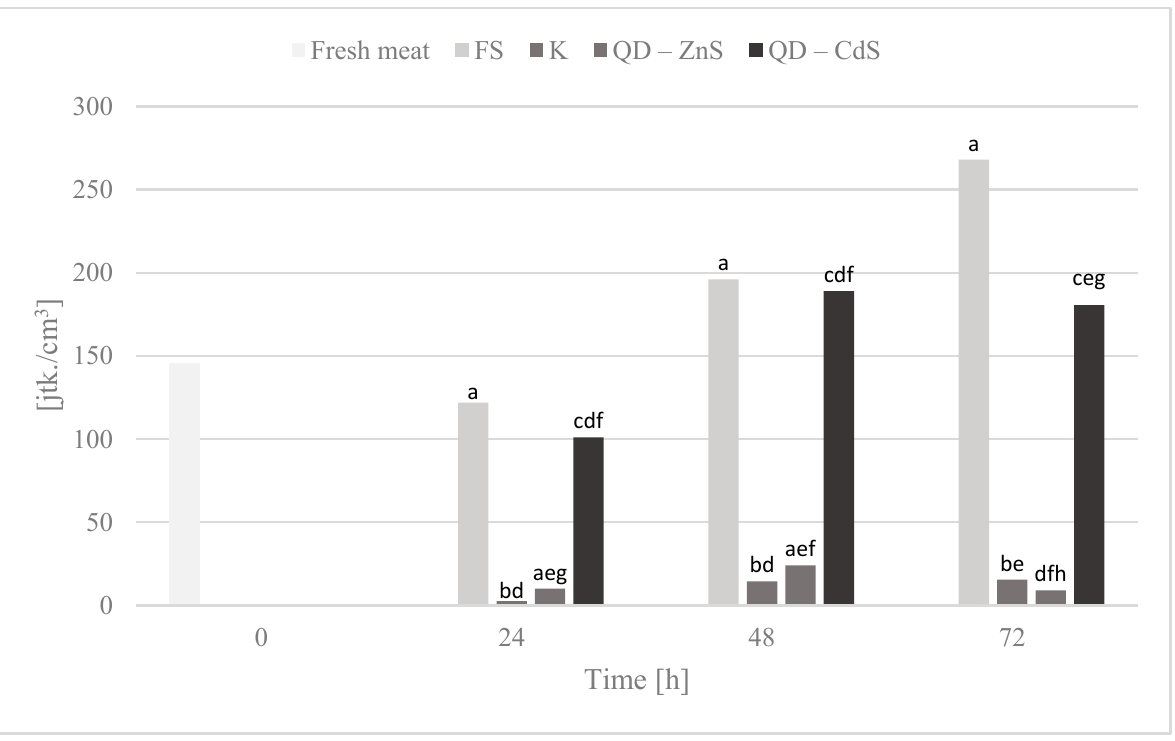
Figure 7. Enterobacteriaceae bacteria count in poultry meat stored under different films at about 4 ◦ C. The parameters in the